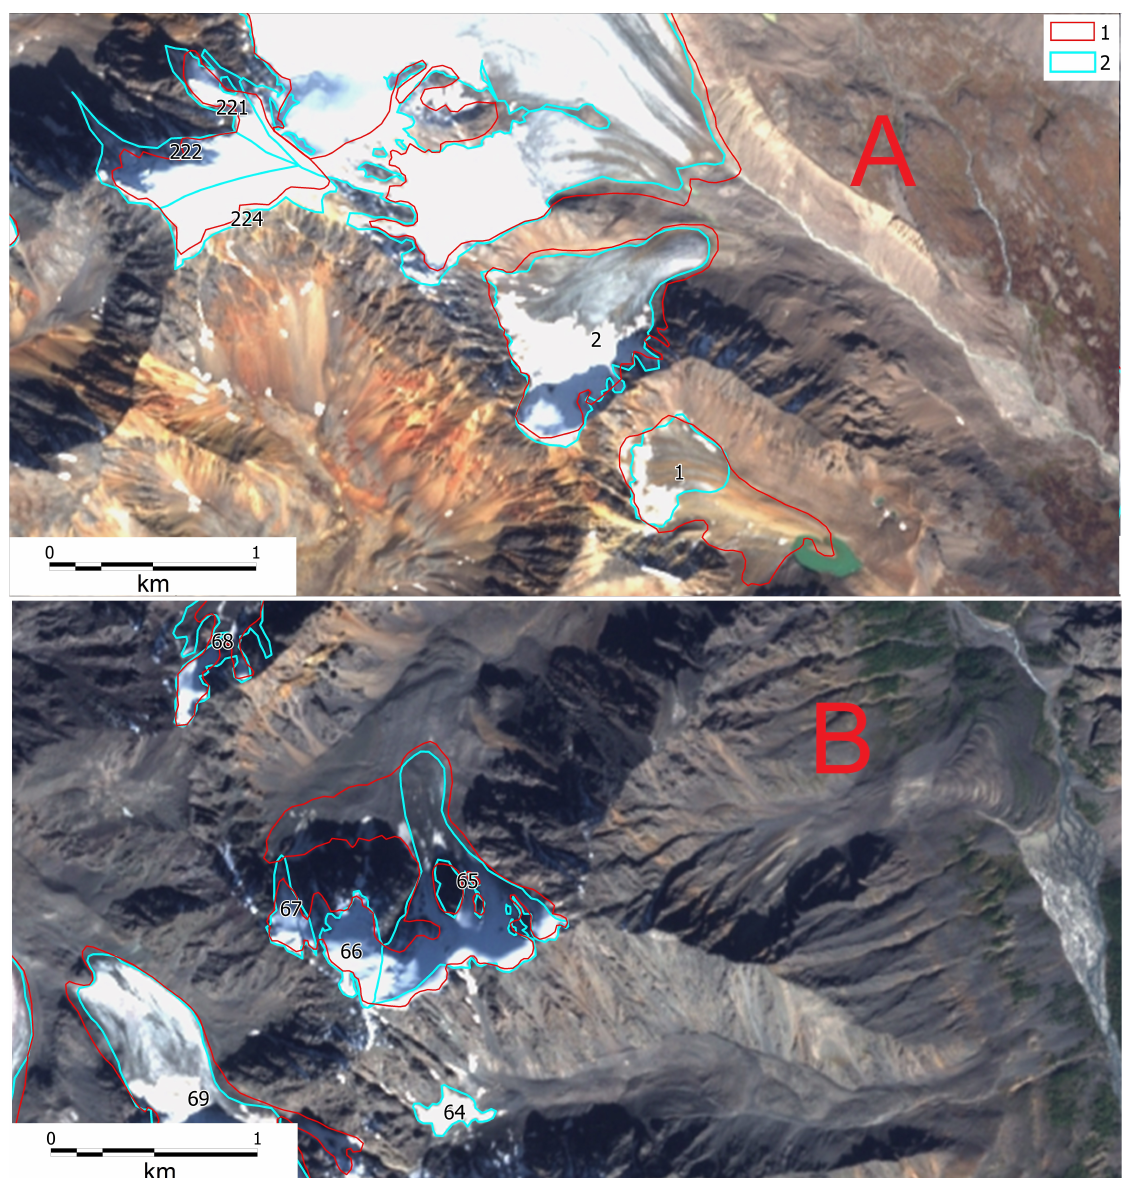
Figure 22. Comparison of glacier contours according to the catalog of glaciers in Russia (1) and according to our catalog (2). ( A ) A plot in the basin of the Dzhelo river; ( B ) plot in the basin of the Maashei